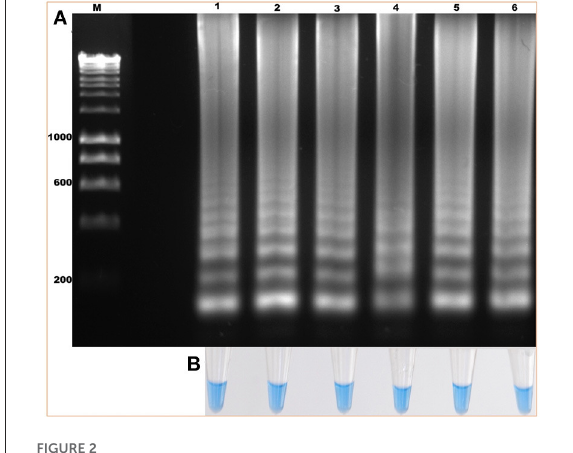
FIGURE2 Evaluation of the amplification temperature of the ama-1 gene of B. bigemina using the loop-mediated isothermal amplification technique (LAMP) technique. (A) Isothermal amplification analysis, by electrophoresis in 1.2% agarose gel stained with red gel. (B) Colorimetric detection of the amplification of the ama-1 gene, visualized with hydroxynaphthol blue. Lanes: (M) Molecular size marker in bp, (1) 60 ◦ C, (2) 61 ◦ C, (3) 62 ◦ C, (4) 63 ◦ C, (5) 64 ◦ C, and (6) 65 ◦ C.